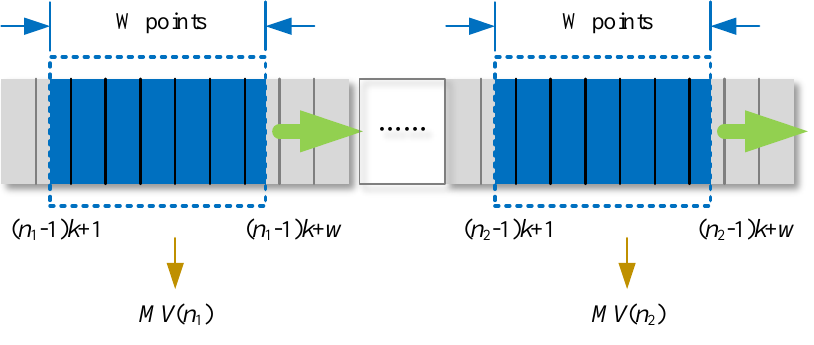
Figure 3. Sliding window model.